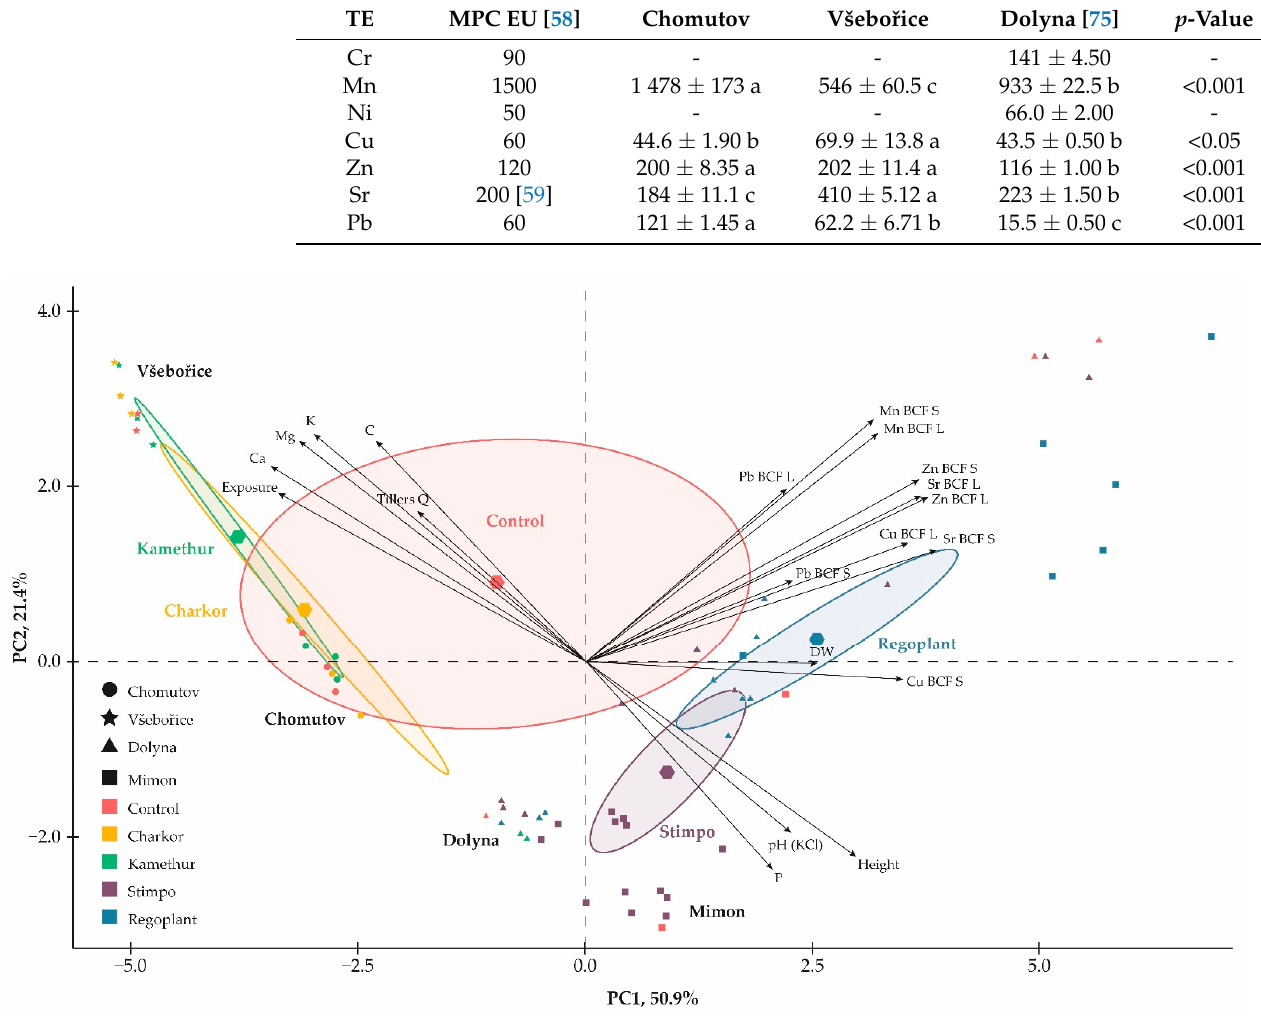
Figure 7. Biplot of PC1 and PC2 for PGRs, plants, and soil data.